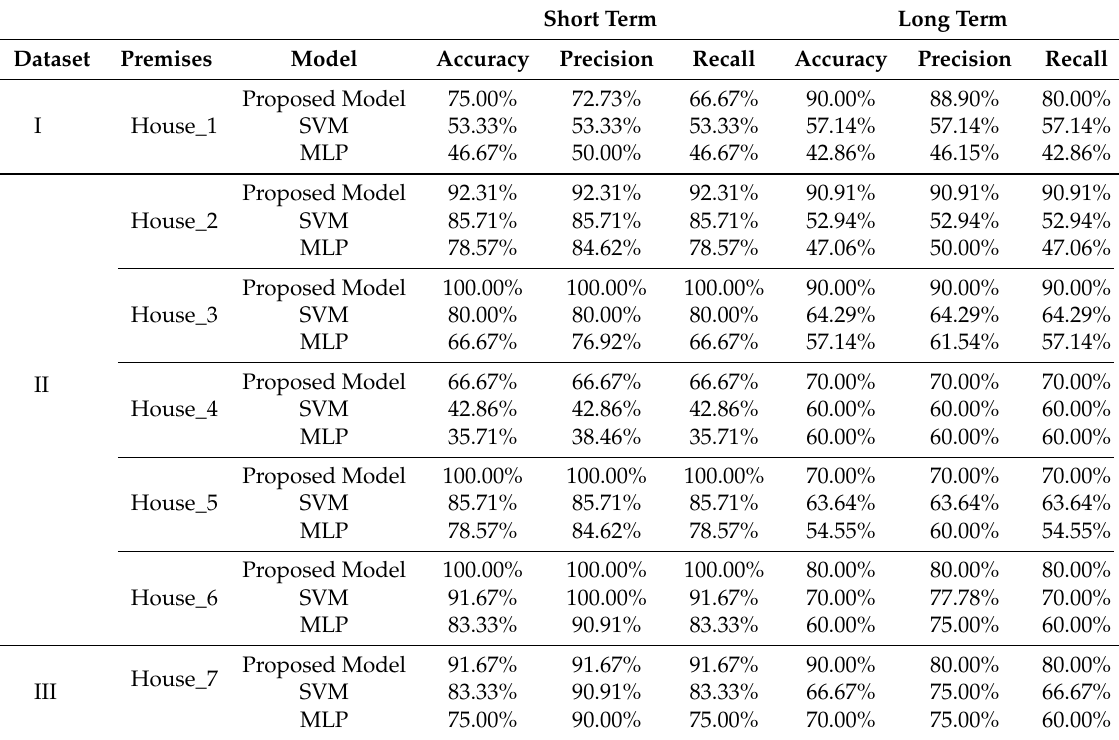
Table 12. Prediction: premise level accuracy, precision, recall @ 50% data as training